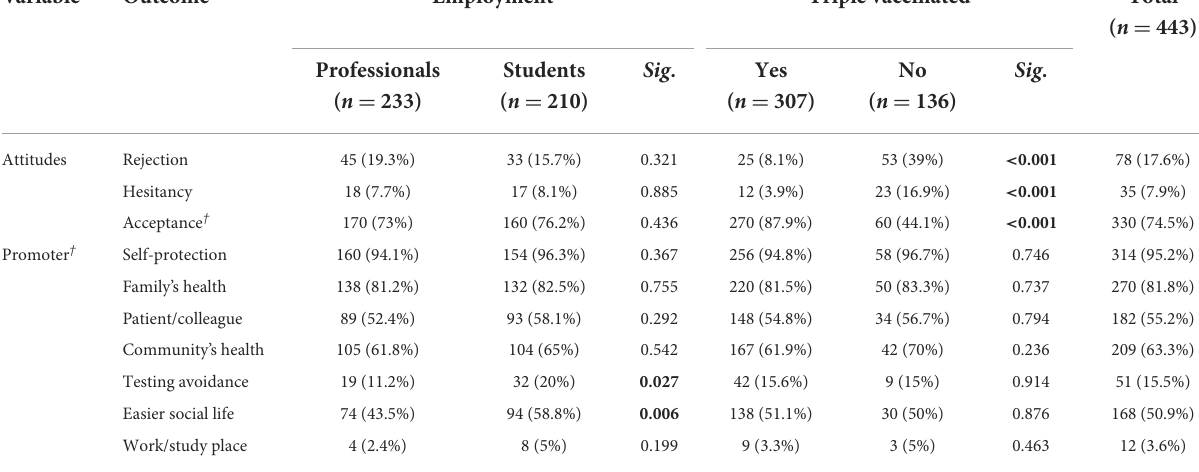
TABLE 3 Attitudes toward COVID-19 VBD of polish healthcare professionals and students responding to COVID-19 VBH survey, December 2021–January 2022 ( n = 443). Variable